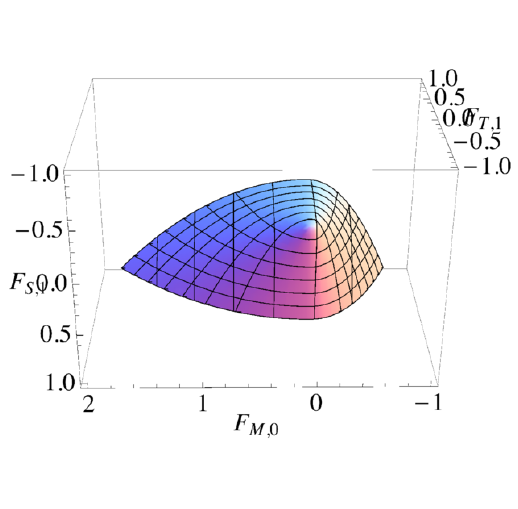
Figure 16 . Similar to (cid:12)gure 15, but imposing a restriction F M; 0 + F M; 1 = 0.